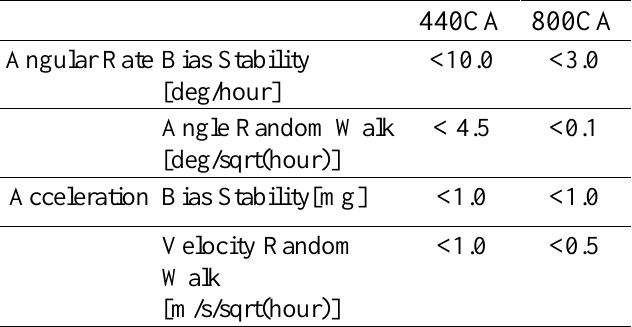
Table 2. IMU Specification Data.